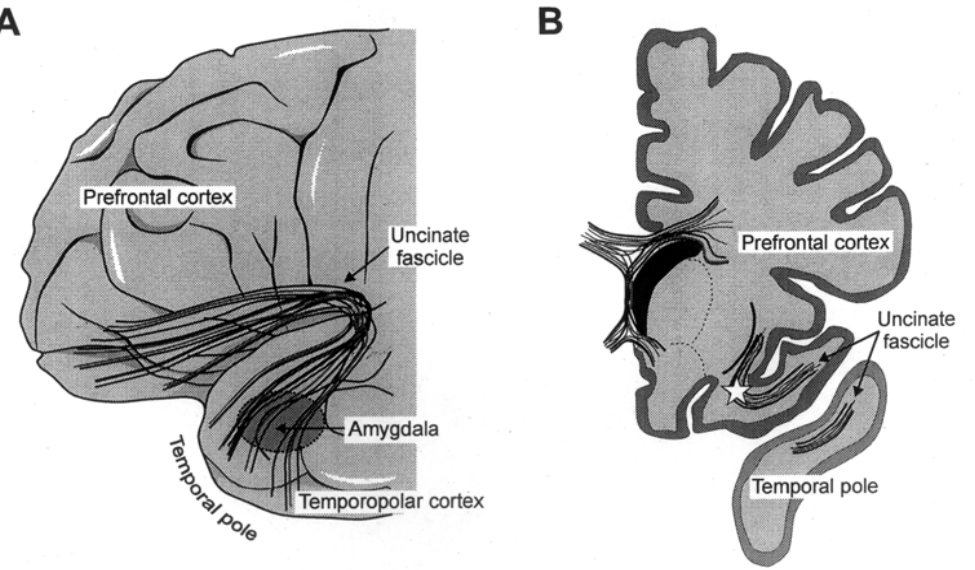
Fig. 1. Sketches of the locus of the (ventral) uncinate fascicle and the amygdala (A) and of the region containing the activity spot in the ventral prefrontal cortex near the uncinate fascicle (B). A: Schematic view of the lateral anterior half of the human cerebral cortex. The course of the ventral branch of the uncinate fascicle, interconnecting the anterior temporal and the ventral prefrontal cortex, and the locus of the amygdala within the anterior medial temporal lobe are shown schematically. B: Coronal section at the level of maximal activation in the region of the uncinate fascicle (star; coordinates: 26 16 − 12). (After Fig. 74 of Talairach and Tournaux